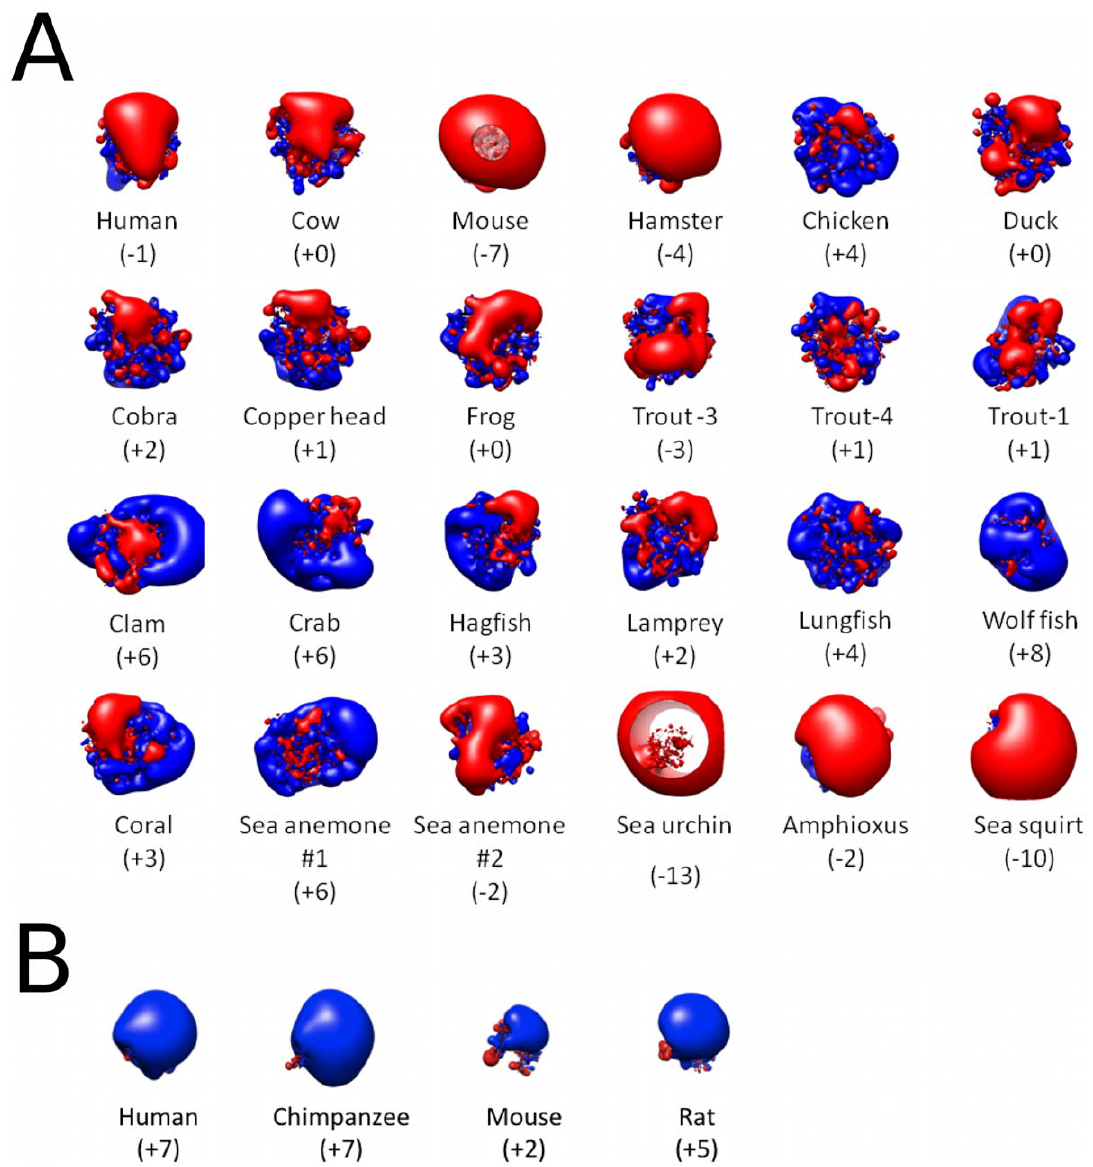
Figure 2. Spatial distributions of electrostatic potential for homologues of C3d and CR2. (A) Electrostatic potential distributions for 24 homologues of C3d [red, negative ( 2 1.5 kT/e); blue, positive (1.5 kT/e)]. (B) Electrostatic potential distributions for 4 homologues of CR2 [red, negative ( 2 1.5 kT/e); blue, positive (1.5 kT/e)]. The net charge (e) of each homologue is provided in the parentheses.